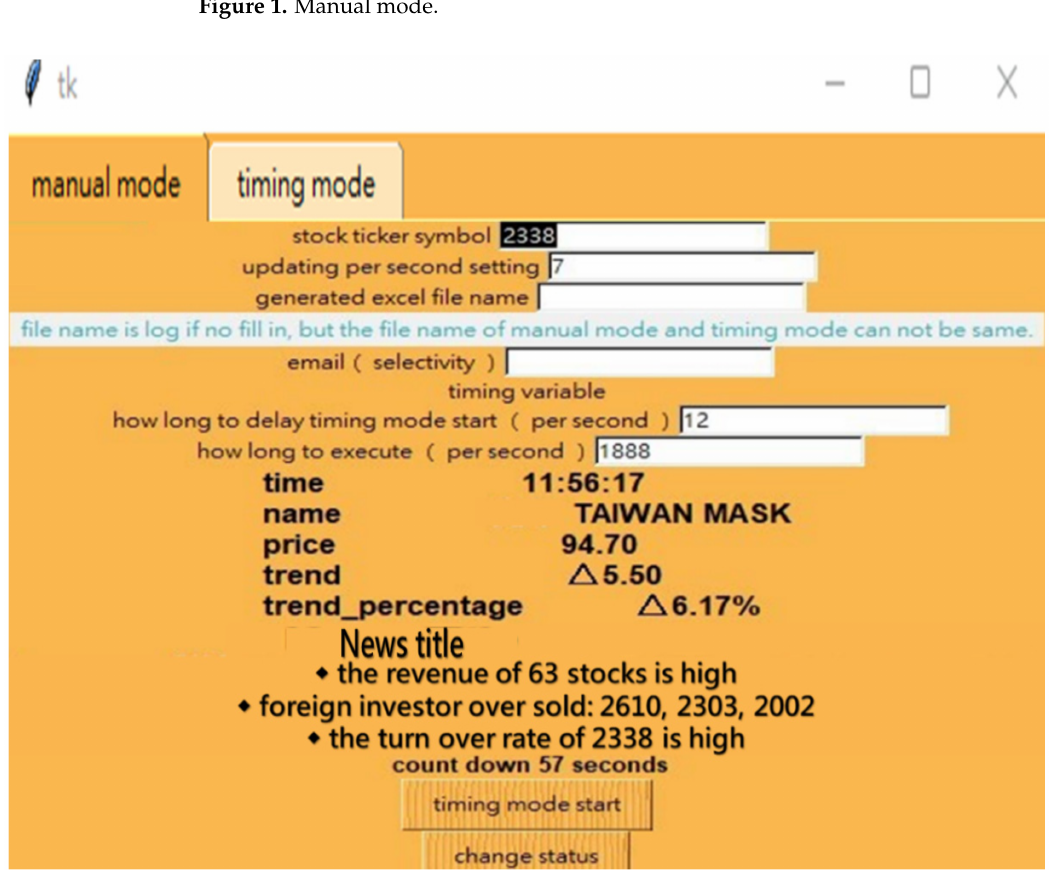
Figure 2. Timing mode with query